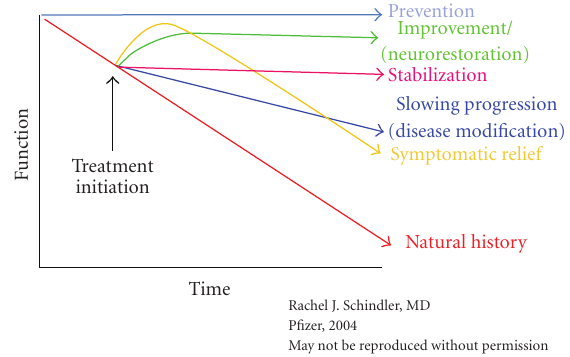
Figure 2: Hypothetical trajectories depicting the changes in level of functioning across time that would be expected due to the natural progression of AD, or with other conceptualized interventions that would produce a symptomatic relief, a disease modifying e ff ect, stabilization, improvement (neurorestoration), or prevention, respectively. Image used with the permission of its creator, Rachel Schindler (Pfizer,